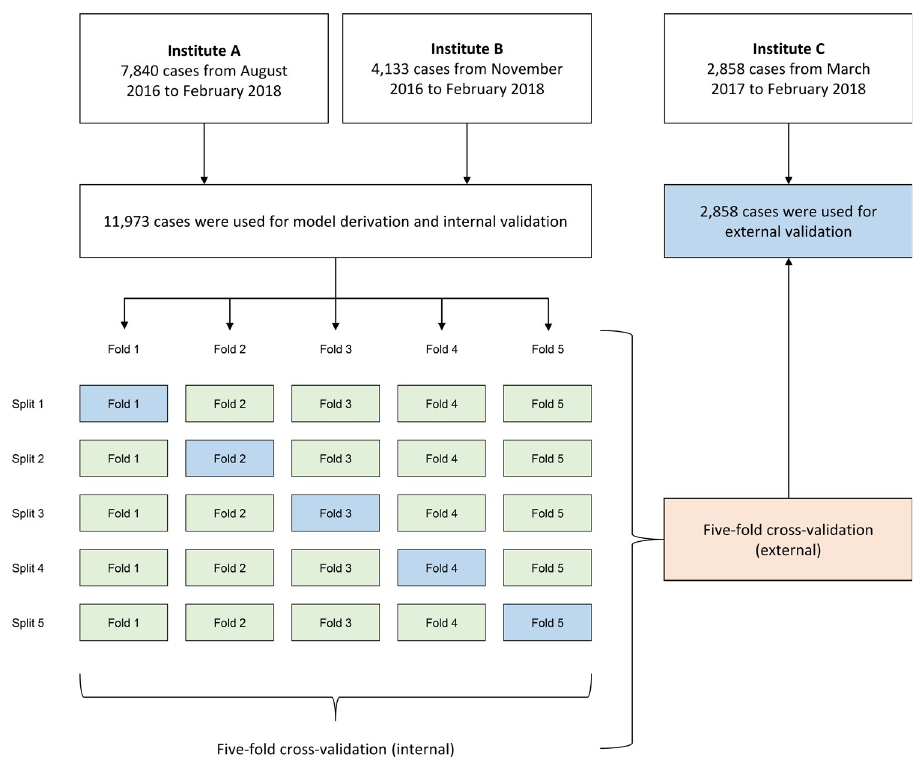
Fig 1. Flow chart of study subjects and the process of five-fold cross